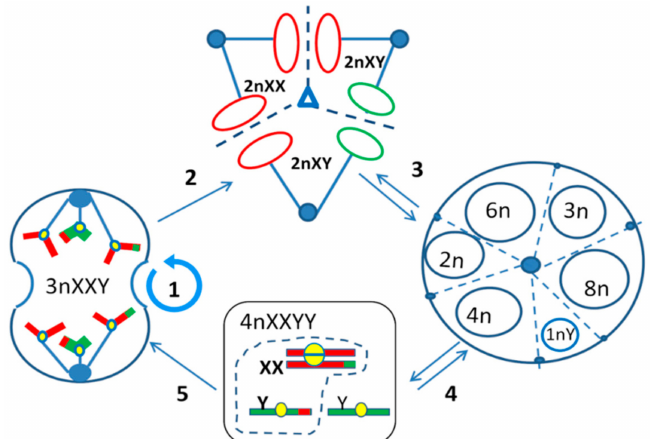
Figure 5. The Digyny Concept of meio-mitosis applied to near-triploid male tumor cells. ( 1 ) A digynic triploidy tumor cell line (3nXXY) undergoes mitotic cycles replicating and segregating sister chromatids for growth of the tumor mass. To perform recombinative renewal, it first closes telomere ends, and after replication segregates the genomes of the 3nXXY(x2) cell in ( 2 ) tripolar mitosis as 2:2:2 by pairwise fusing the haploid whole genome products of karyokinesis (red circles for arbitrary maternal, green, for paternal genomes) at each pole. ( 3 ) A diploid progeny (2nXY) endoreduplicates to 4n XXYY, and to 8n; a triploid subnucleus can also endoreplicate to 6n; 1n Y can be also (rarer) produced in tripolar mitosis (3:2:1); ( 4 ) 4n as a subnucleus of the polyploid giant cancer cell (PGCC) or as a free cell enters the recombinative pseudo-meiosis followed by one-step reduction division (for “maternal” sub-nucleus) and two-step reduction (for “paternal” sub-nucleus). A digyny-like fusion in 3n XXY subcell is processed (a dashed box). Alternatively (less likely), one non-recombined 1nY subnucleus from tripolar mitosis of a triploid cell (3:2:1) can fuse with two recombined, unreduced maternal genomes of a pseudo-meiotic diploid sub-cell. ( 5 ) A renewed digynic triploid cell restarts mitotic cycling, the process constitutive for tumor near-triploidy and favoring cell survival by compensating lethal recessive mutations. The near-diploid tumors can also enter this hybrid cycle induced through endoreduplication and multipolar mitosis, and thus be converted into triploid digynic stem-line